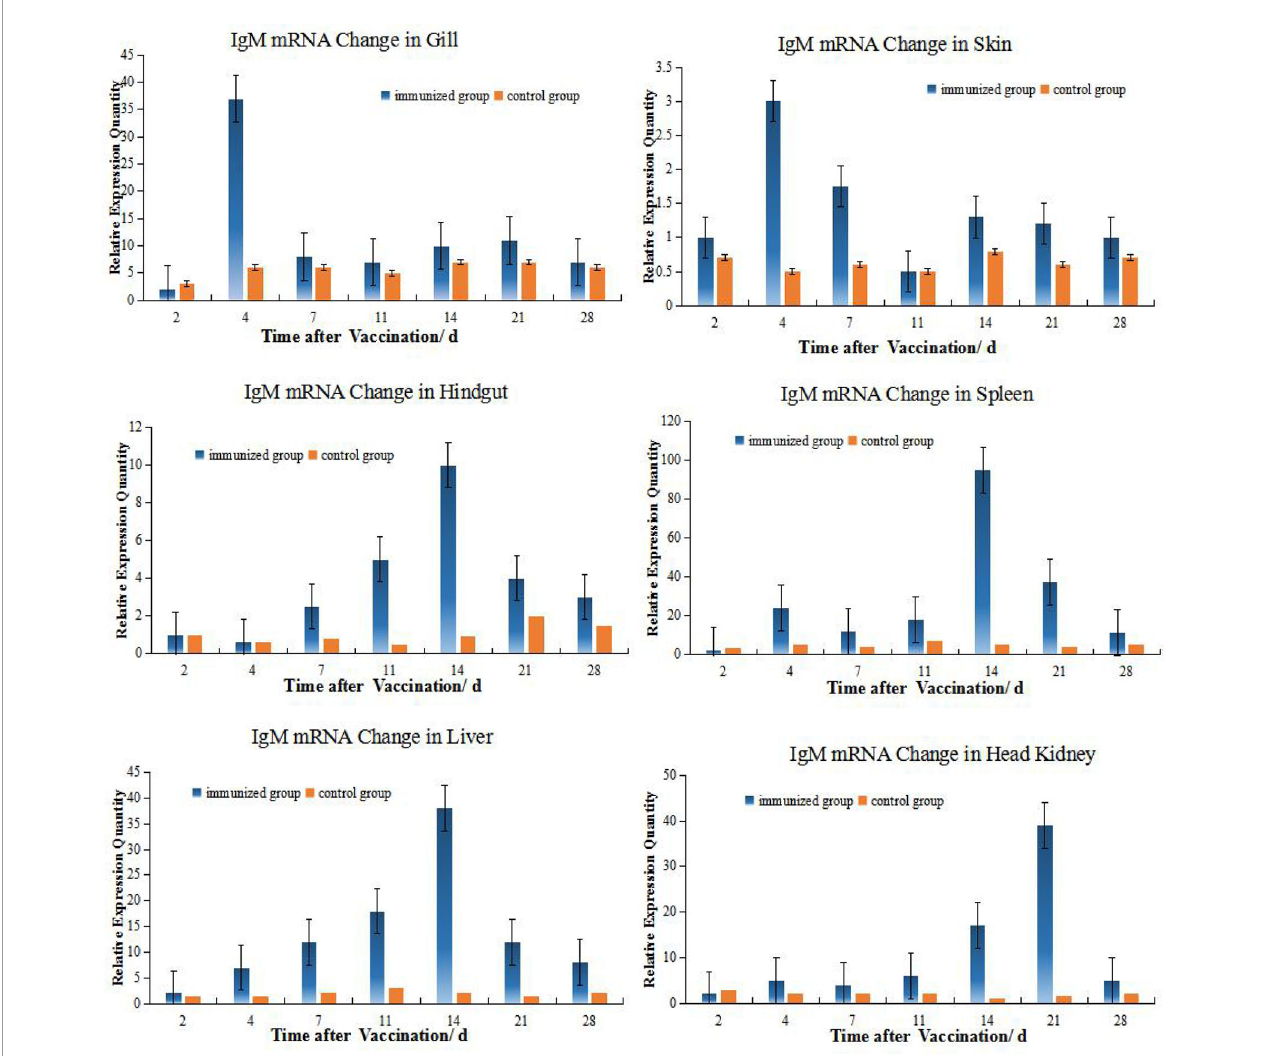
FIGURE 3 | Relative quanti fi cation of grouper IgM gene mRNA in different organs. The relative abundance for IgM mRNA from the tissues was ranked as spleen > HK> liver>gill> hindgut>skin. The alterations in mRNA levels over time were similar for the hindgut, liver, and spleen with increases at day 14 post-inoculation. Organ IgM mRNA expression levels changed with time and the hindgut, liver and spleen followed the same temporal